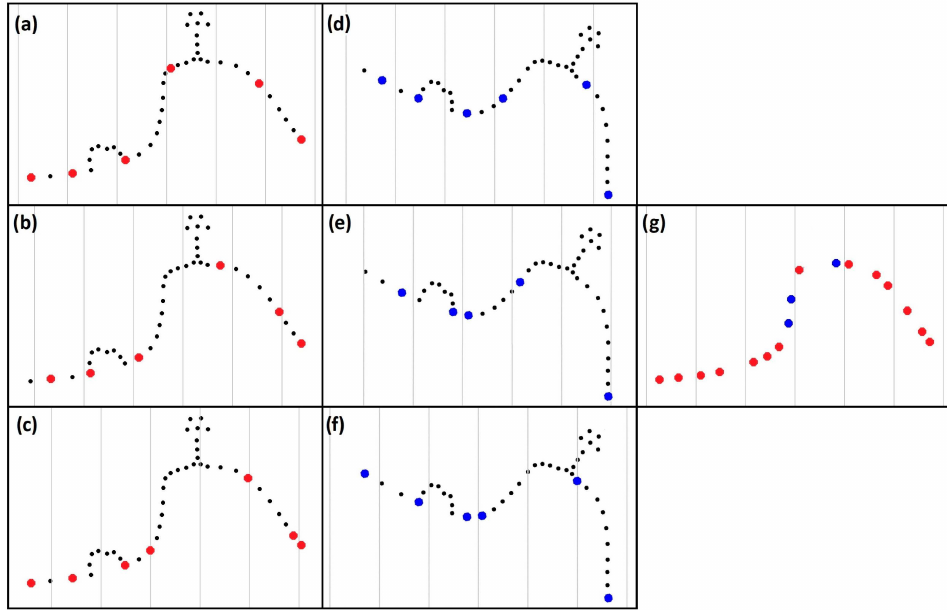
Figure 1. Principle of the method: ( a – c ) vertical raster in 3 steps (i.e., shifted 3 times)—red points; ( d – f ) rotated raster in 3 steps (i.e., one rotation shifted 3 times)—blue points; ( g ) resulting terrain points identified in the respective